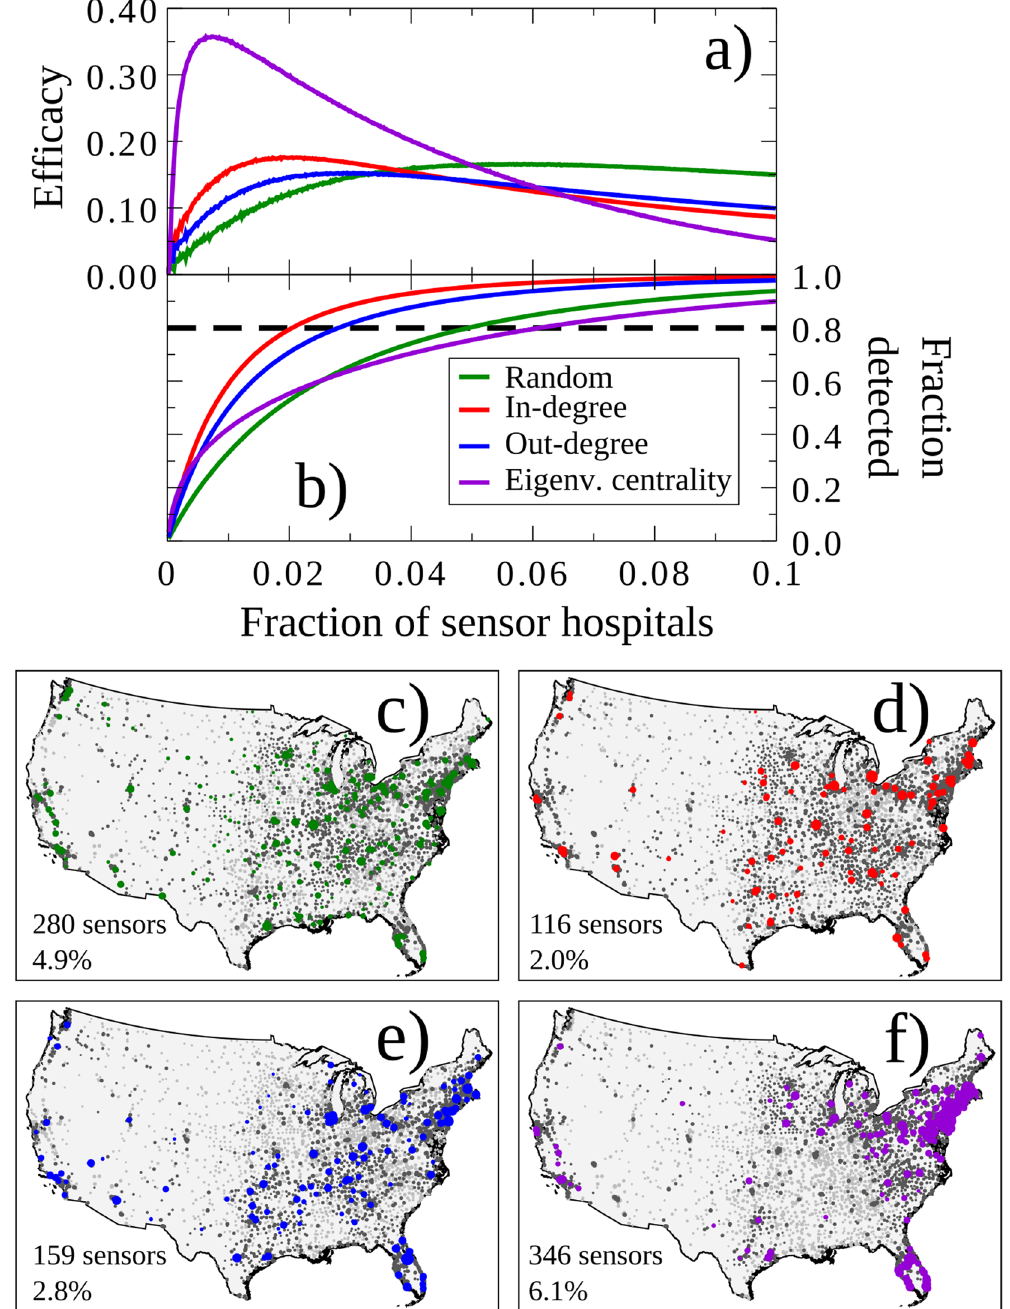
Figure 3. Efficacy and spatial locations of optimal sensors. ( a ) Efficacy of strategies. When focusing on the most efficacious sensor set for each strategy, eigenvector centrality results in the smallest sensor set, followed by in- degree, out-degree, and the random strategy. Sensor sets are selected using the four possible strategies at 80% coverage of C. difficile cases in panel ( b ). Panels ( c , d , e and f ) show instances of the sensor sets at 80% coverage for the different strategies (in-degree, out-degree, random, eigenvector centrality). The colored nodes are included in the sensor set, the dark gray nodes are neighbors of the sensor hospitals, and the light gray nodes are not covered by the sensor set. Hospital size is proportional to the number of C. difficile cases in that hospital. The in-degree strategy uses the least number of sensors and it is followed by the out-degree and then the random strategy. The eigenvector centrality strategy unexpectedly performs worse than the random strategy. The maps were created using the Basemap Matplotlib Toolkit 1.0.8 (http://matplotlib.org/basemap/) for Python 24